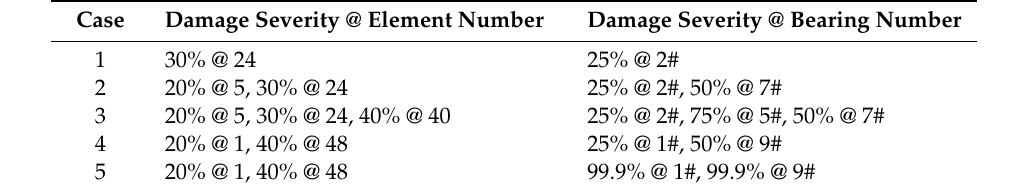
Figure 5. The 8-span continuous beam. Table 5. Five damage cases.